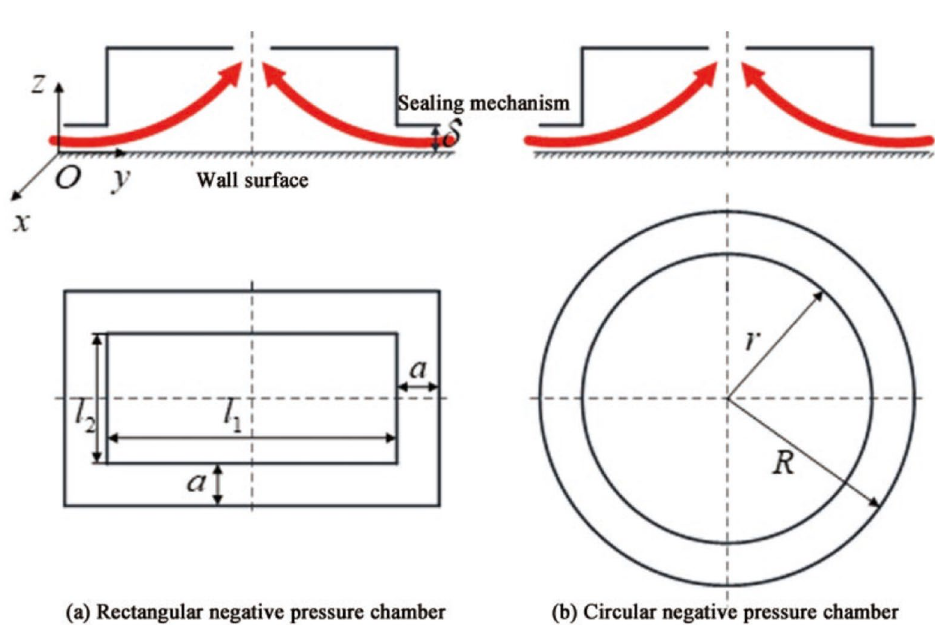
Figure 2. Structure model of negative pressure